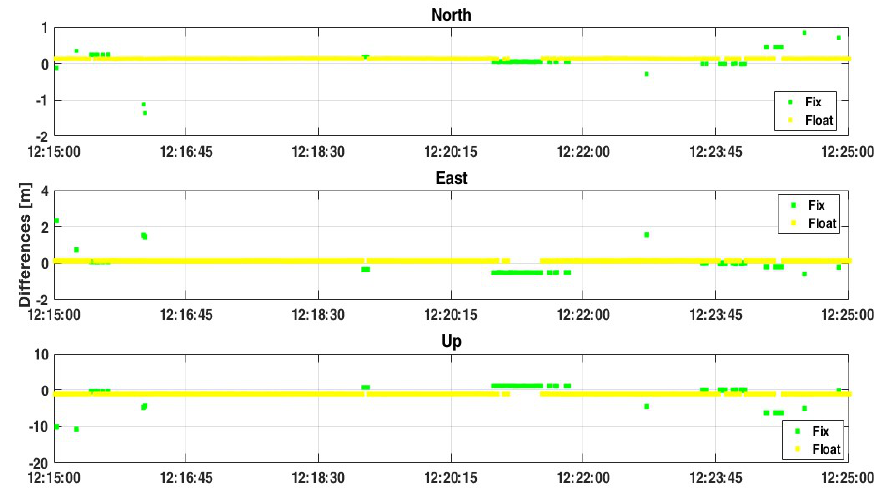
Figure 5. Positioning results considering case 1, with GPS-only constellation, L1 frequency, “continuous” method for the ambiguity resolution and ratio = 3.